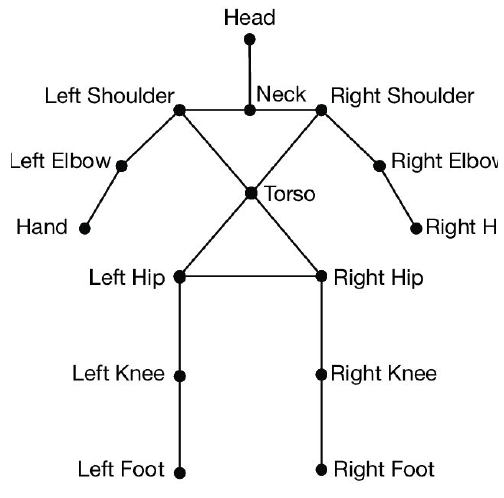
Fig. 7 Human skeleton and